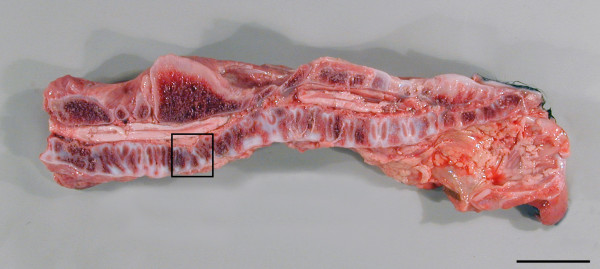
Widespread malformation of vertebrae in a case of the brachyspina syndrome (DK2). Widespread malformation and disorganisation of cervical, thoracic and lumbar vertebrae. Notice the fusion of the spinous processes of thoracic vertebrae. The thoraco-lumbar junction is not cut in midline due to the presence of a scoliosis. The framed area is shown in detail in Figure 3. Bar = 5 cm.